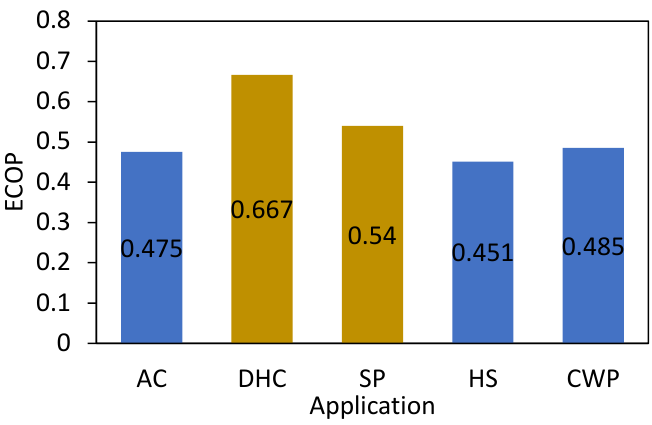
Figure 17. ECOP achieved for each application.